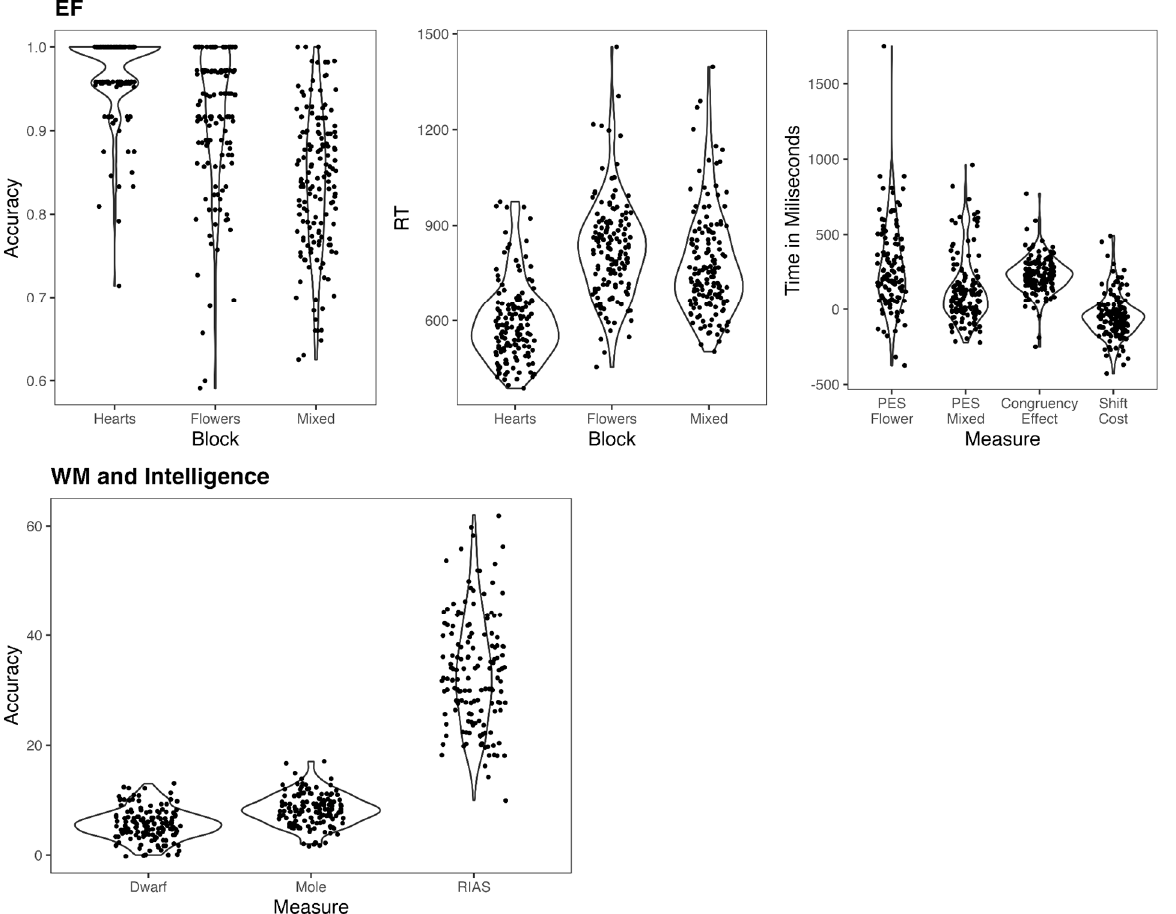
Figure 1. Violin plots of measures from EF, WM, and intelligence